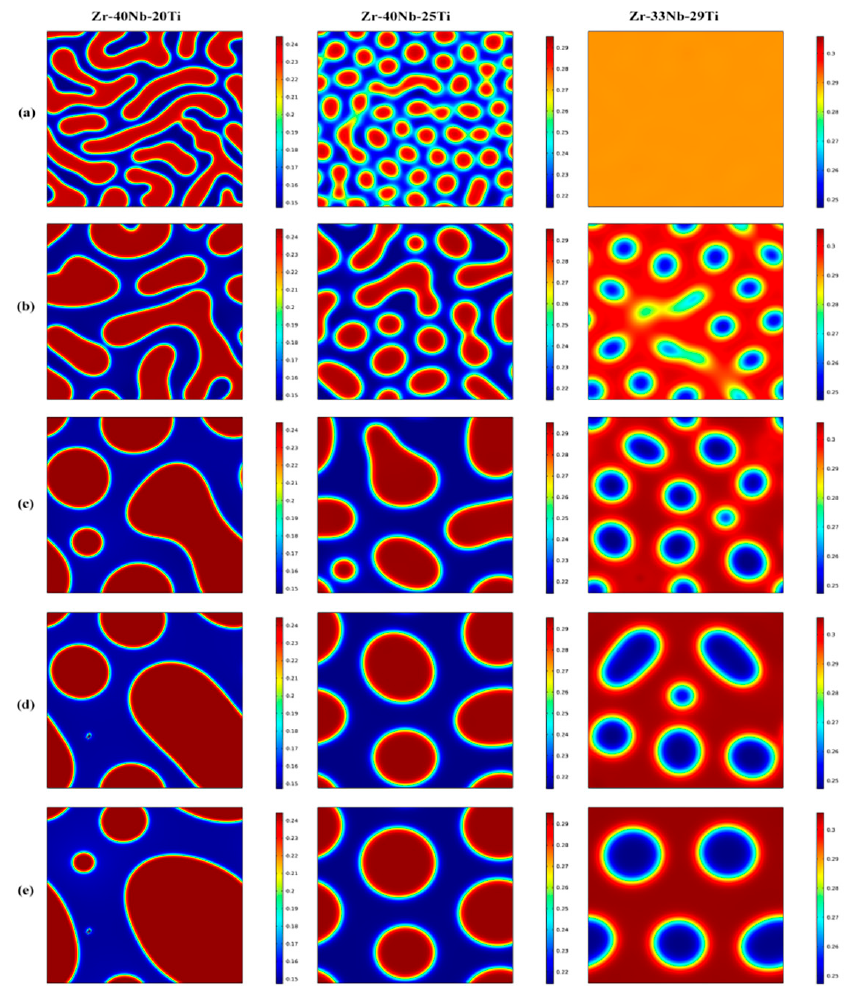
Figure 1. The microstructure evolution of the Zr-33Nb-29Ti, Zr-40Nb-25Ti and Zr-40Nb-20Ti alloys aged at 900 K for different times ( a ) 20 min, ( b ) 100min, ( c ) 500 min, ( d ) 1000 min and ( e ) 2000 min (the blue region refers the Ti-rich phase and the red region refers the Ti-poor phase). For the Zr-40Nb-25Ti alloy, the Ti-rich phases were in a discrete droplet-like shape in the early aging stage. With the increase in aging time, the discrete fi ne droplet-like phases were constantly fused together, resulting in an increasing size and a decreasing number of the Ti-rich phases, but the Ti-rich phases always maintained the discrete drop- let-like shape. In contrast to the fi rst two alloys, the occurrence of spinodal decomposition in the Zr- 33Nb-29Ti alloy needed a longer time at 900 K. After being aged at 900 K for 100 min, the spinodal phases can be obviously observed in the Zr-33Nb-29Ti alloy. The Ti-poor phases were in the discrete droplet-like shape, embedding in the substrate of the Ti-rich phase of the Zr-33Nb-29Ti alloy, forming a distinct droplet star spot pa tt ern. With the increase in